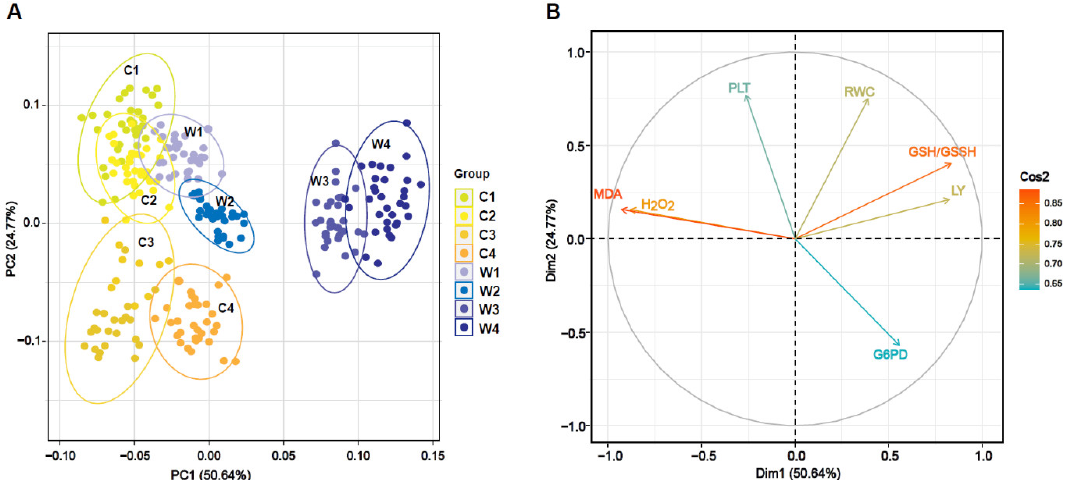
Figure 3. Natural clustering of crisp grass carp and ordinary grass carp. ( A ) Scatter plot of PCA scores from ordinary grass carp and crisp grass carp at different culturing stages. C1, C2, C3, and C4 represent the ordinary grass carp from 30, 60, 90, and 120 day, respectively. W1, W2, W3, and W4 represent the crisp grass carp from 30, 60, 90, and 120 day, respectively. ( B ) Loading plot for the original variables in the first two principal components (PCs).